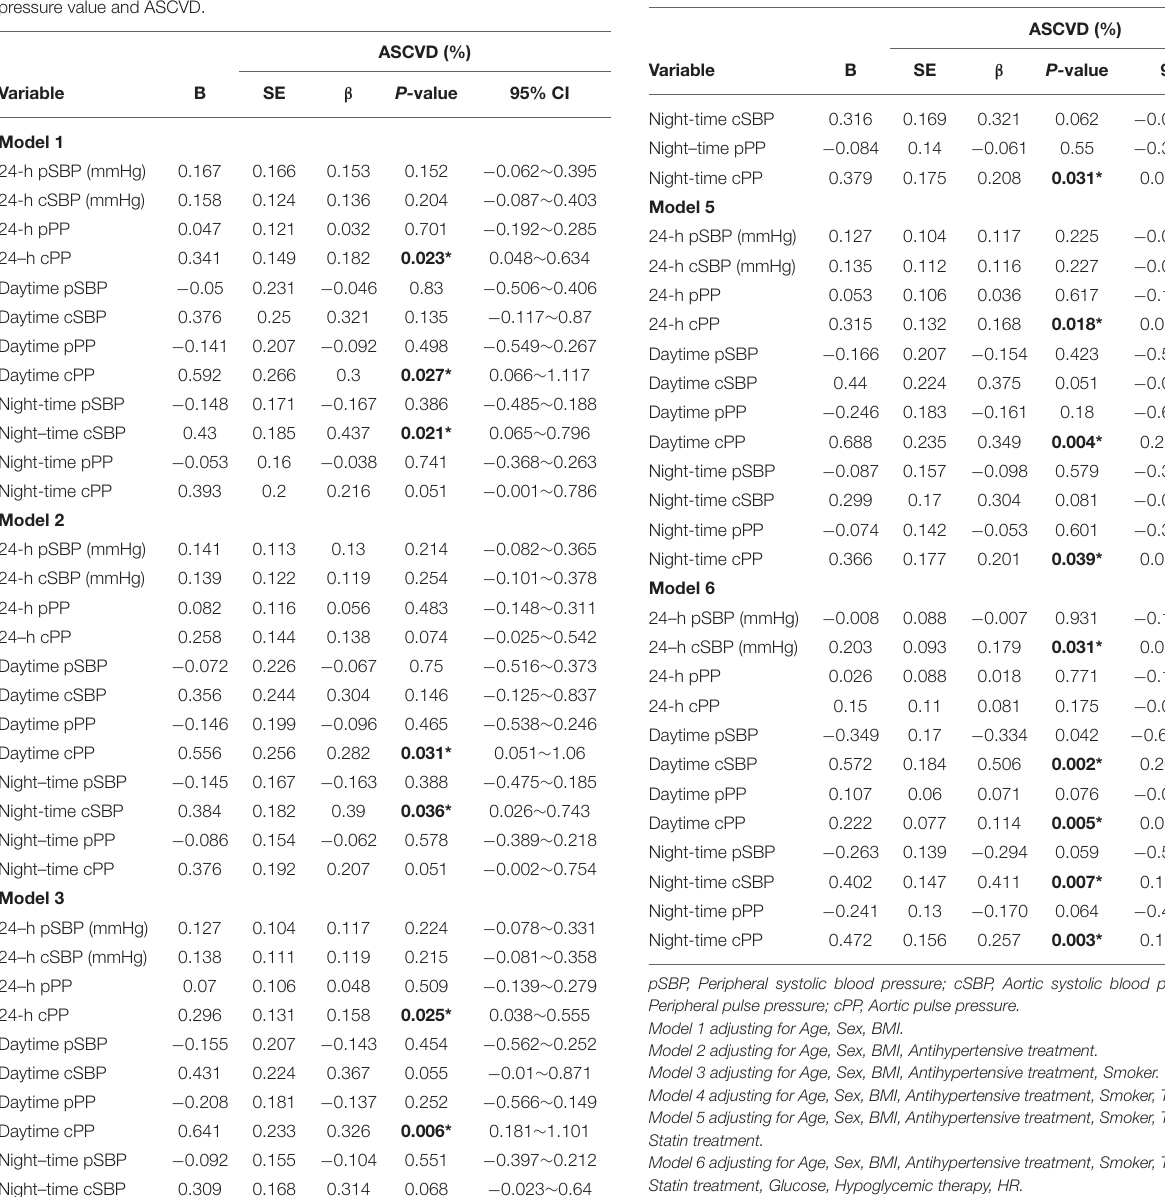
TABLE 4 | Linear regression analysis of associations between each blood pressure value and ASCVD.